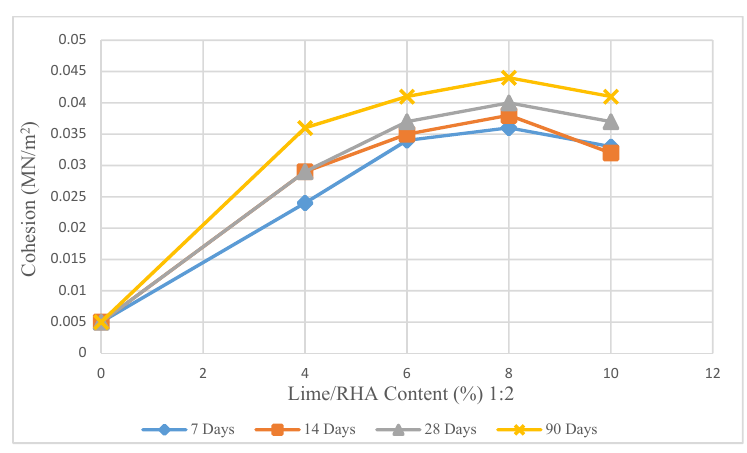
Materials 2021 , 14 , x FOR PEER REVIEW Figure 10. Effect of lime/RHA 1:1 content on cohesion. Figure 10. Effect of lime/RHA 1:1 content on cohesion.